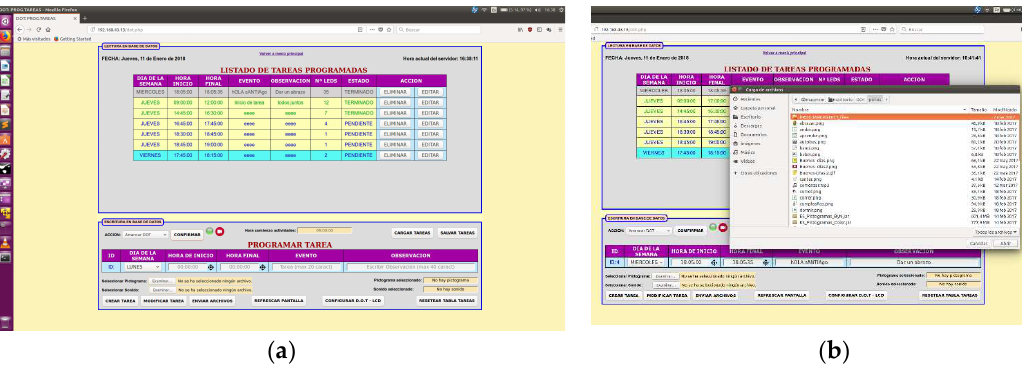
Figure 5: (a) Spanish TOD HMI main menu. (b) pop up window for multimedia file selection. 6